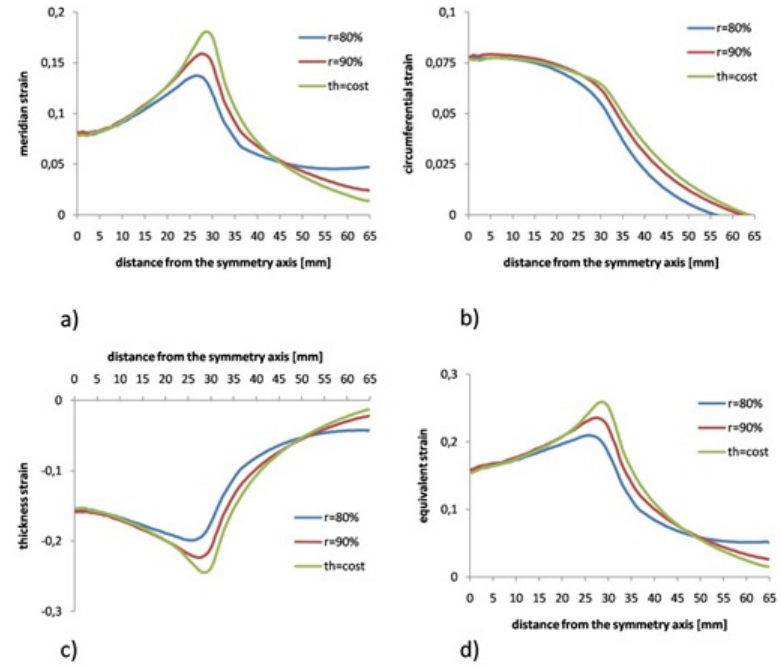
Figure 7. Comparison between the main strains and the equivalent strain during the stretching process on a constant (th = cost) and a variable (r = 80% e r = 90%) thickness sheet in friction conditions with a friction coefficient µ = 0.1 due to FEM: ( a ) meridian strain; ( b ) circumferential strain; ( c ) thickness strain; ( d ) equivalent strain.